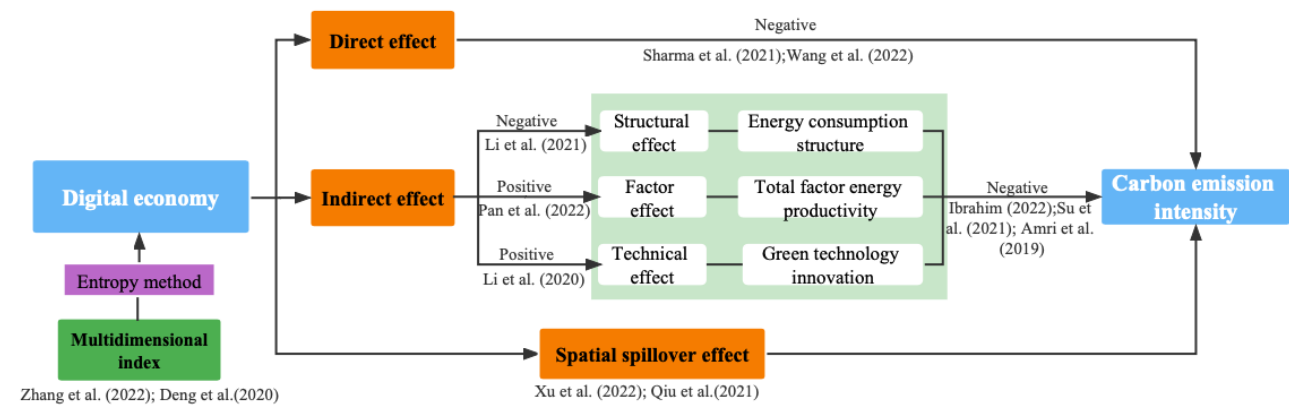
Figure 1. Mechanism analysis of digital economy on carbon emission intensity [20,42,53,70 – 76].